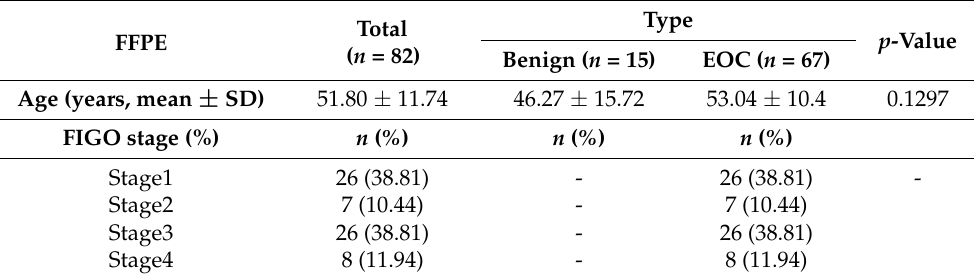
Table 1. Characteristics of the FFPE sample from